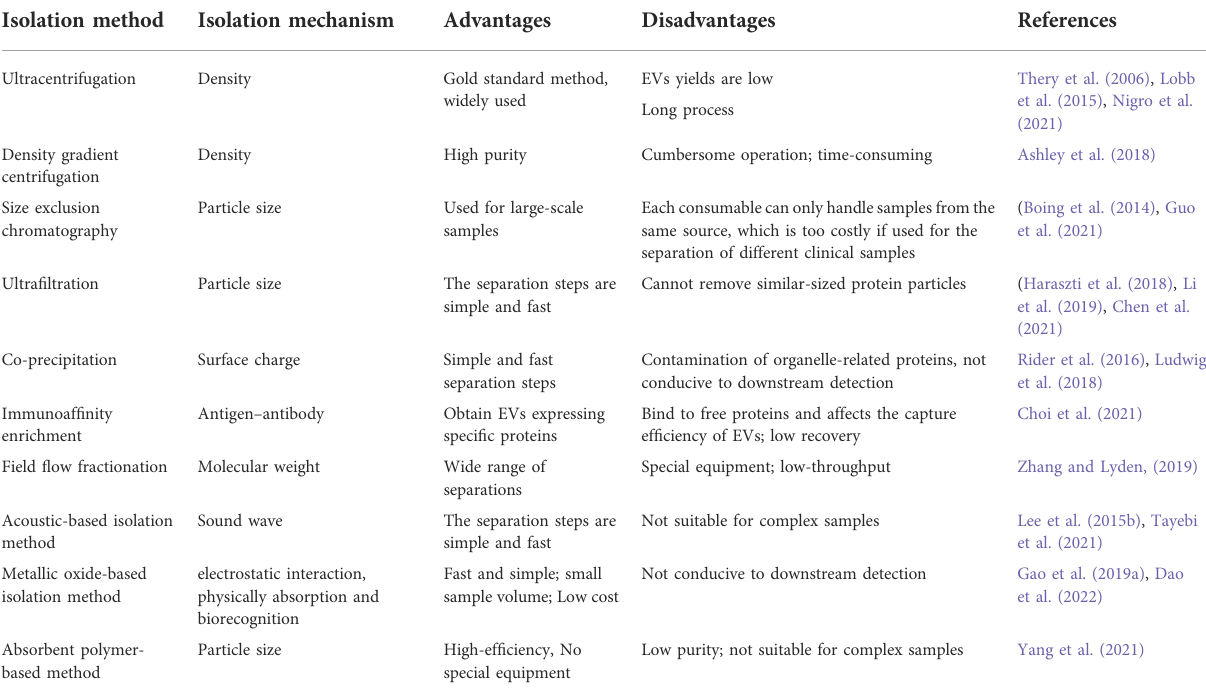
TABLE 1 Summary of EV isolation